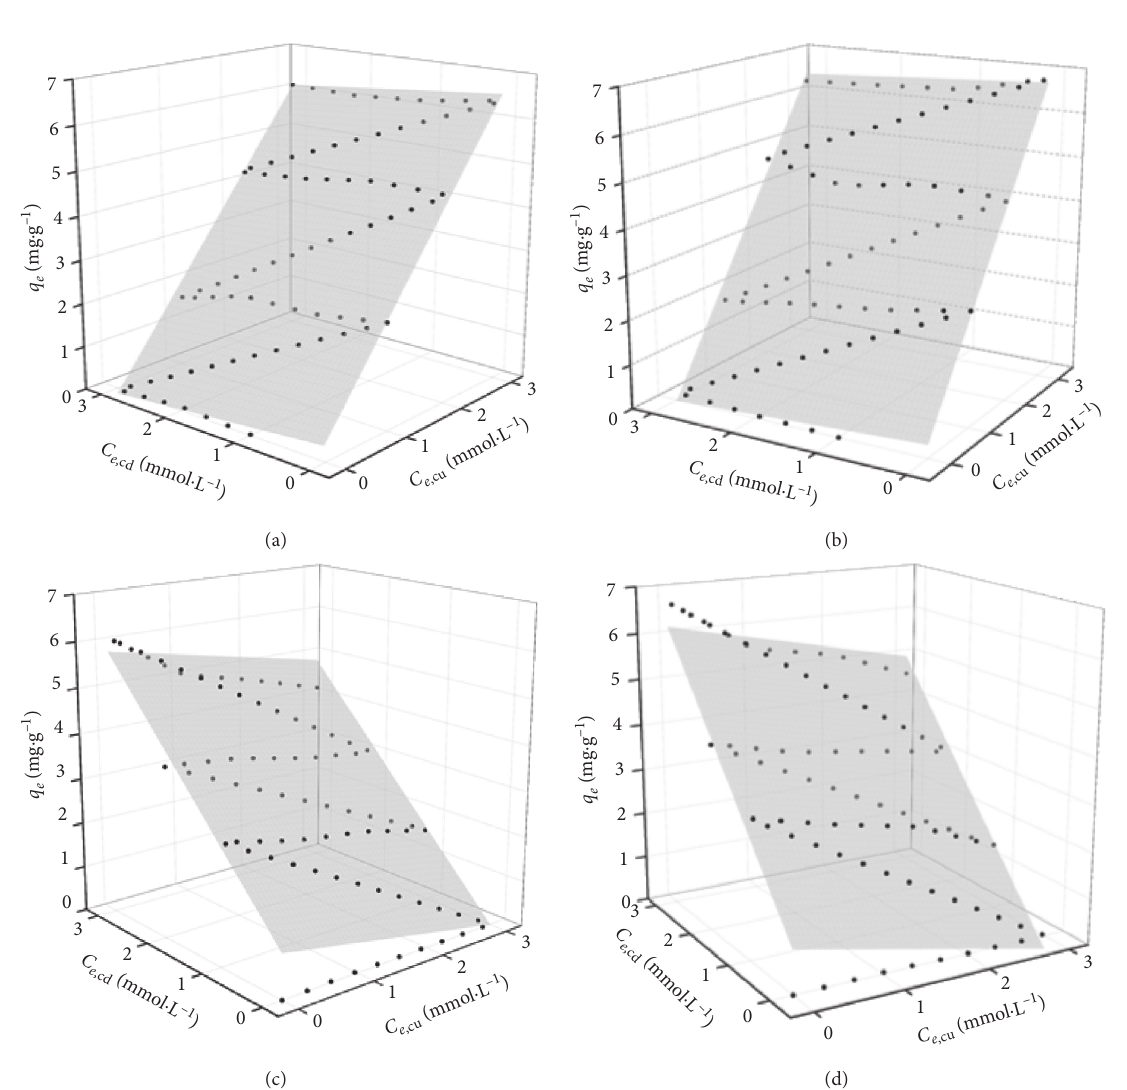
Figure 6: Experimentally interpolated (symbols) and calculated (surface) isotherms for sorption in Cd-Cu systems. The adsorption amounts of (a) Cd(II) by PS, (b) Cd(II) by Na-PS, (c) Cu(II) by PS, and (d) Cu(II) by Na-PS, respectively. The Y -axis is the individual metal adsorption amount, the X -axis is the concentration of Cd(II), and the Z -axis is the concentration of Cu(II). PS means Pisha sandstone; Na-PS means Pisha sandstone modified with Na +